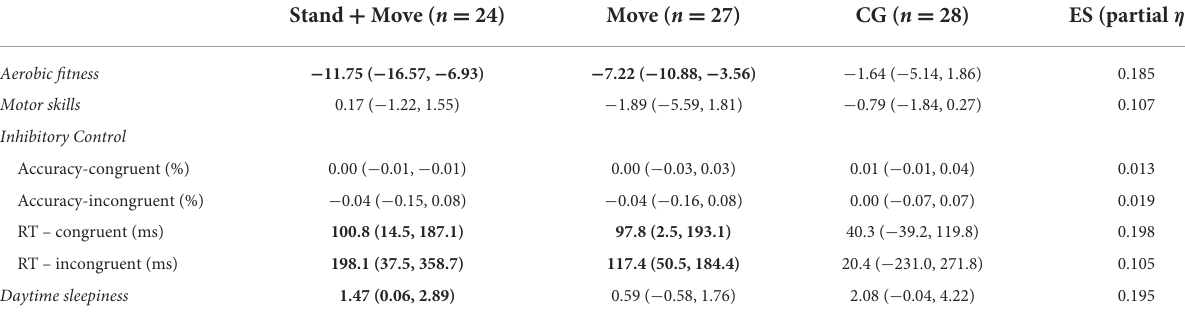
TABLE 3 Adjusted mean changes (95% CI) from baseline to post-intervention.